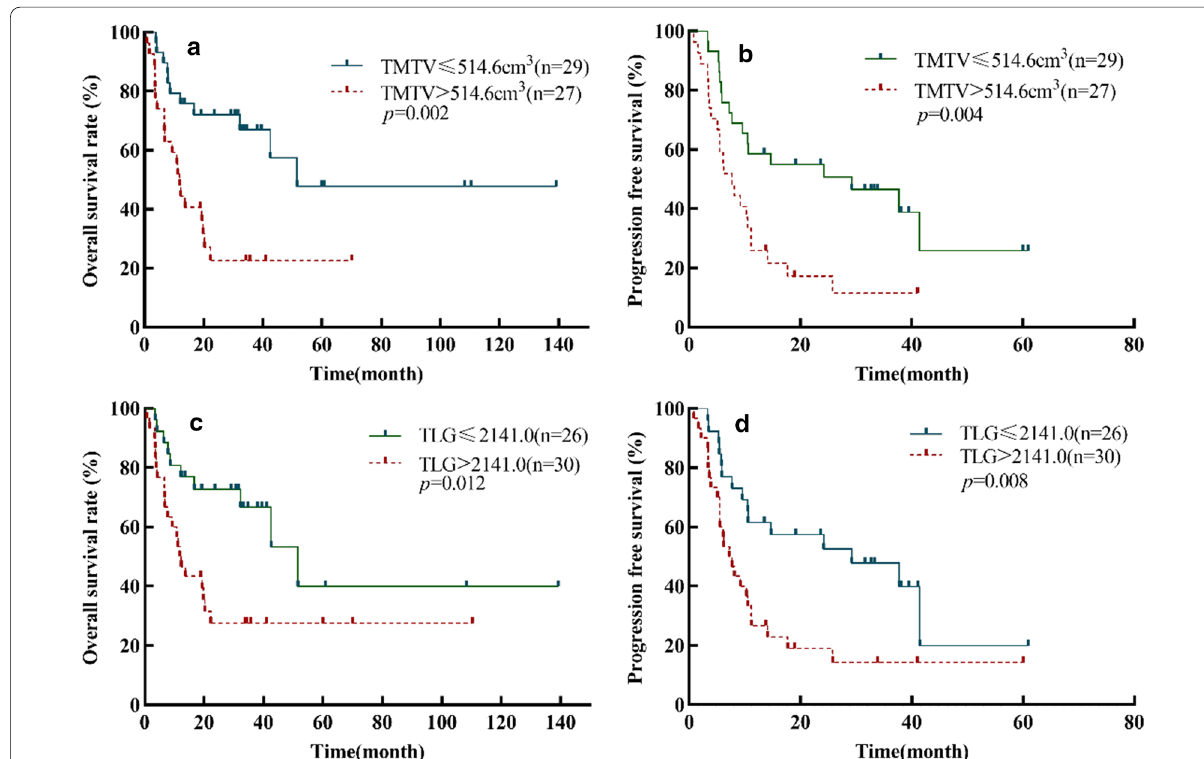
Fig. 1 The Kaplan–Meier survival analyses and curves of OS and PFS according to TMTV ( a , b ) and TLG ( c , d ). p value was acquired by the log-rank